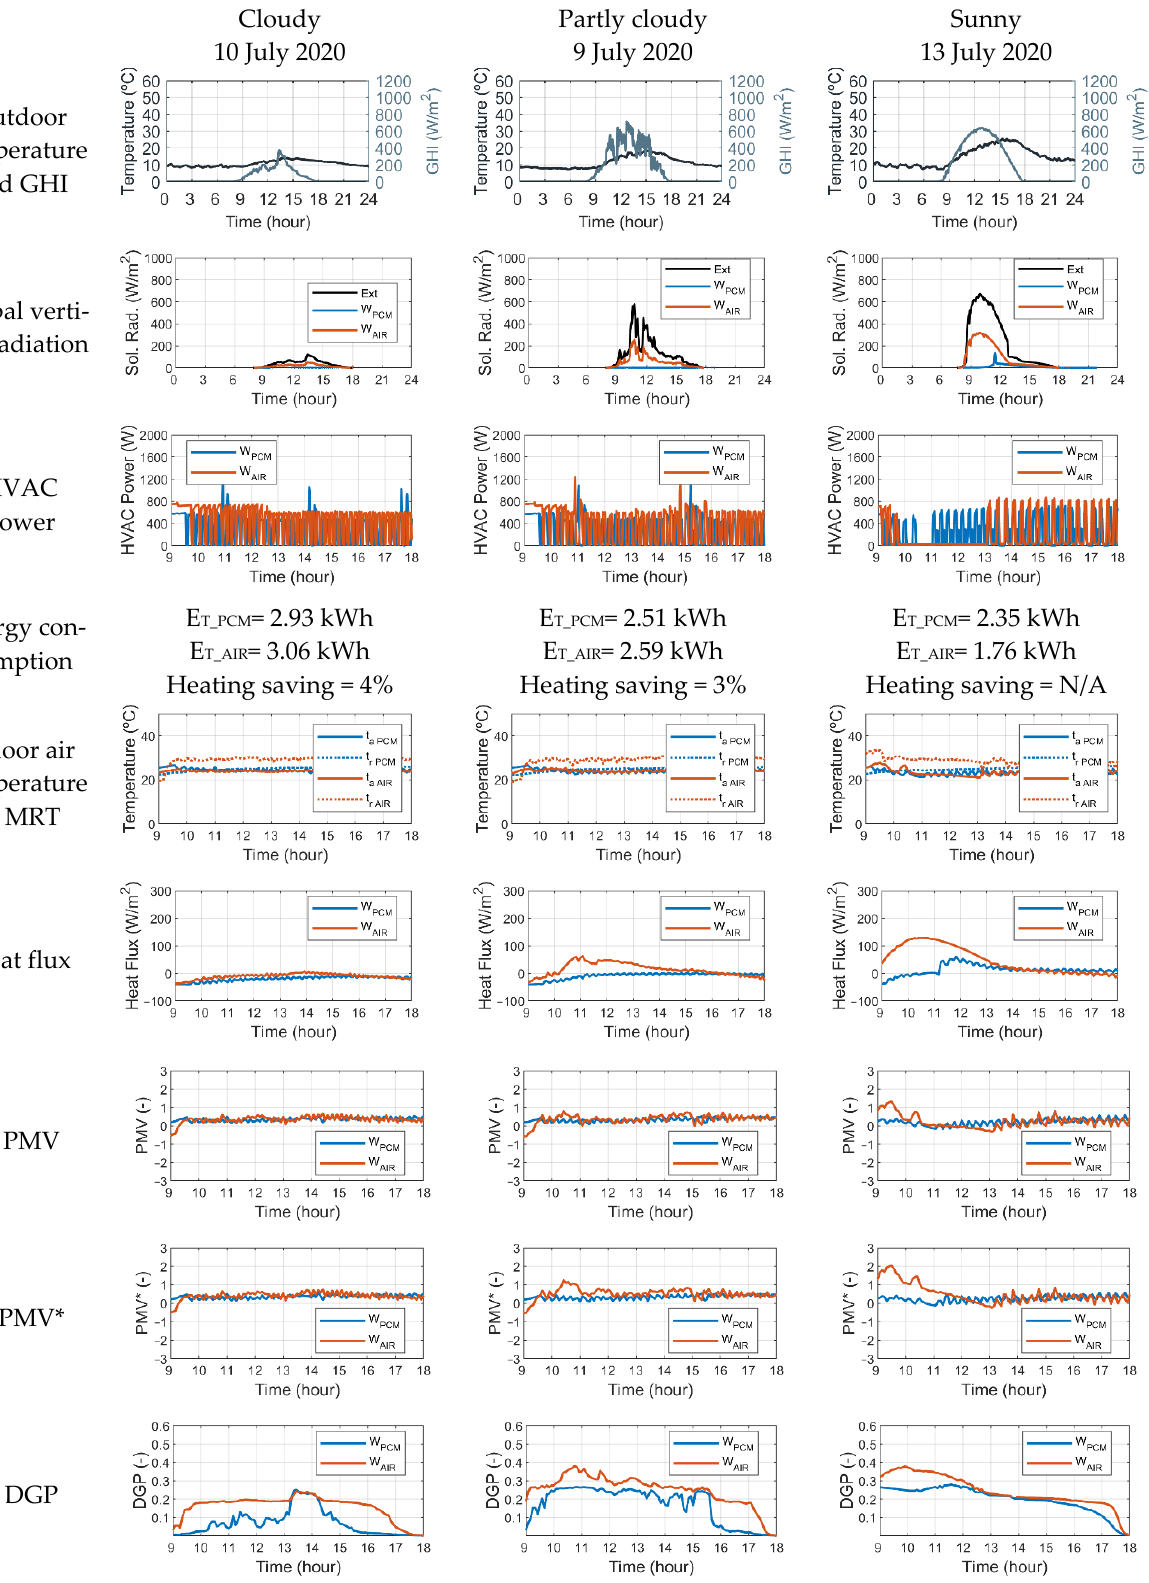
Figure 11. Results for representative days of mid-season cold. ( a ) Outdoor temperature and global horizontal radiation (GHI); ( b ) global vertical radiation; ( c ) HVAC power and energy consumption; ( d ) indoor air temperature & mean radiant temperature (MRT); ( e ) heat flux; ( f ) PMV; ( g ) PMV*; ( h ) DGP. Cloudy Partly cloudy Sunny